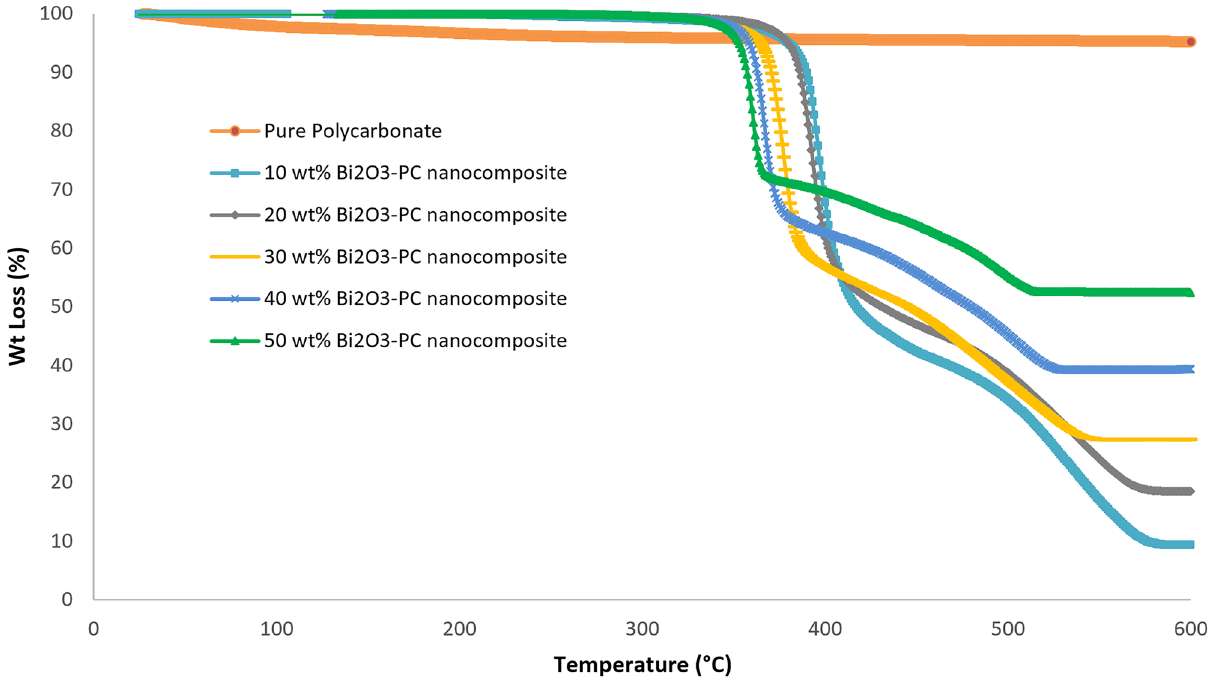
Figure 5. TGA thermograms of nanocomposites containing different levels of Bi 2 O 3 .